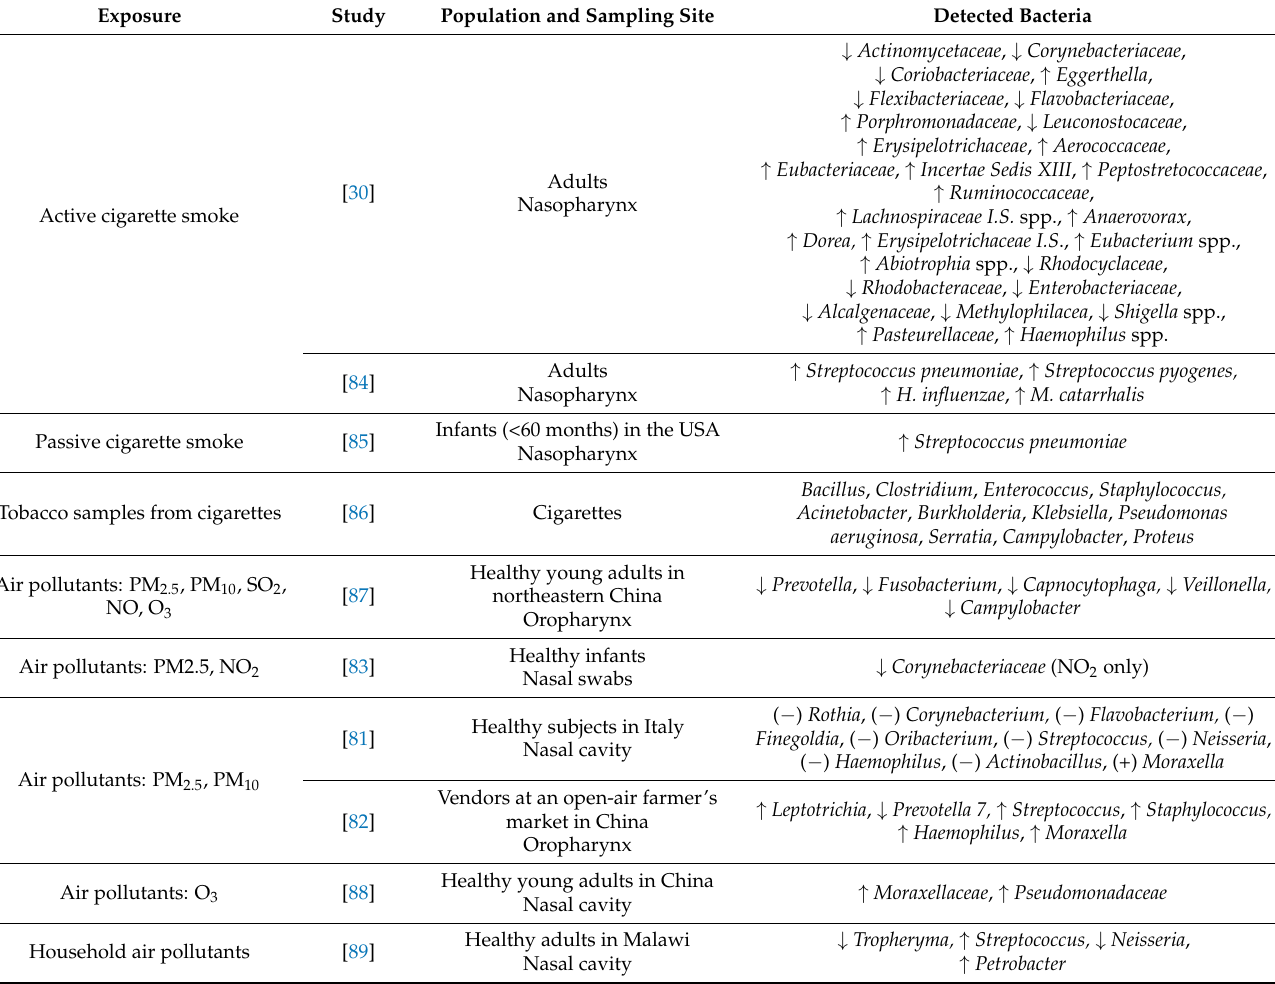
Table 2. Environmental exposures and the changes in the UA